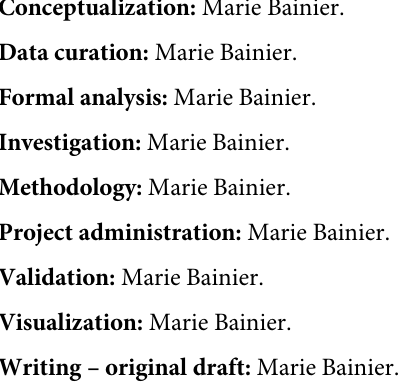
S1 Raw data. Fig 4: Surgeons assessment of model fidelity. S2 Raw data. Fig 5: 3D printed model